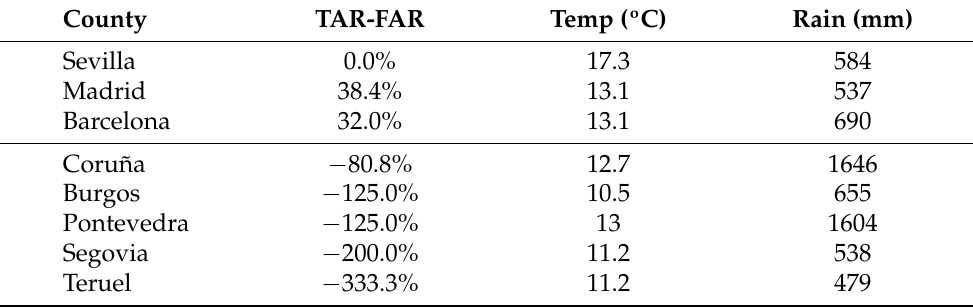
Table 10. Difference between TAR-LAR according to geographic